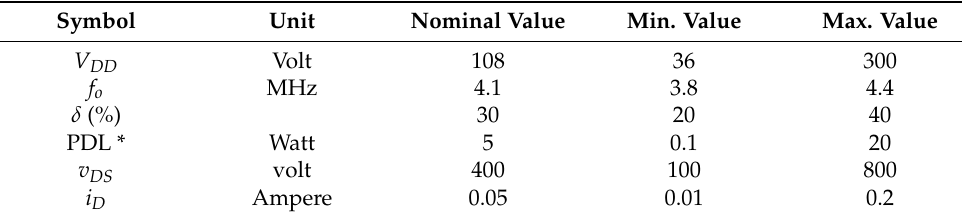
Table 3. The nominal input/output parameters of the class-E amplifier and WPT system.